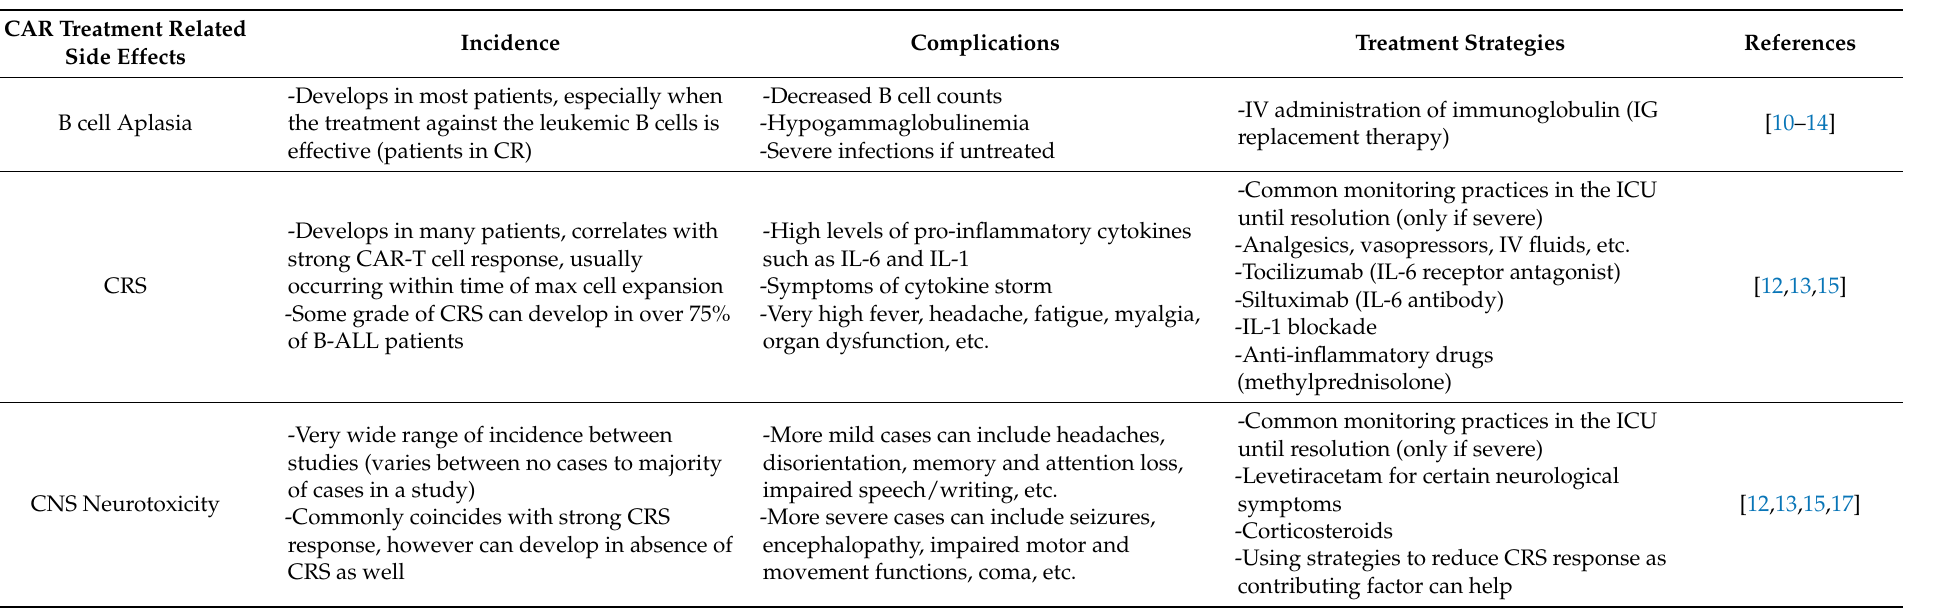
Table 2. Major CAR Treatment Related Side Effects for B-ALL